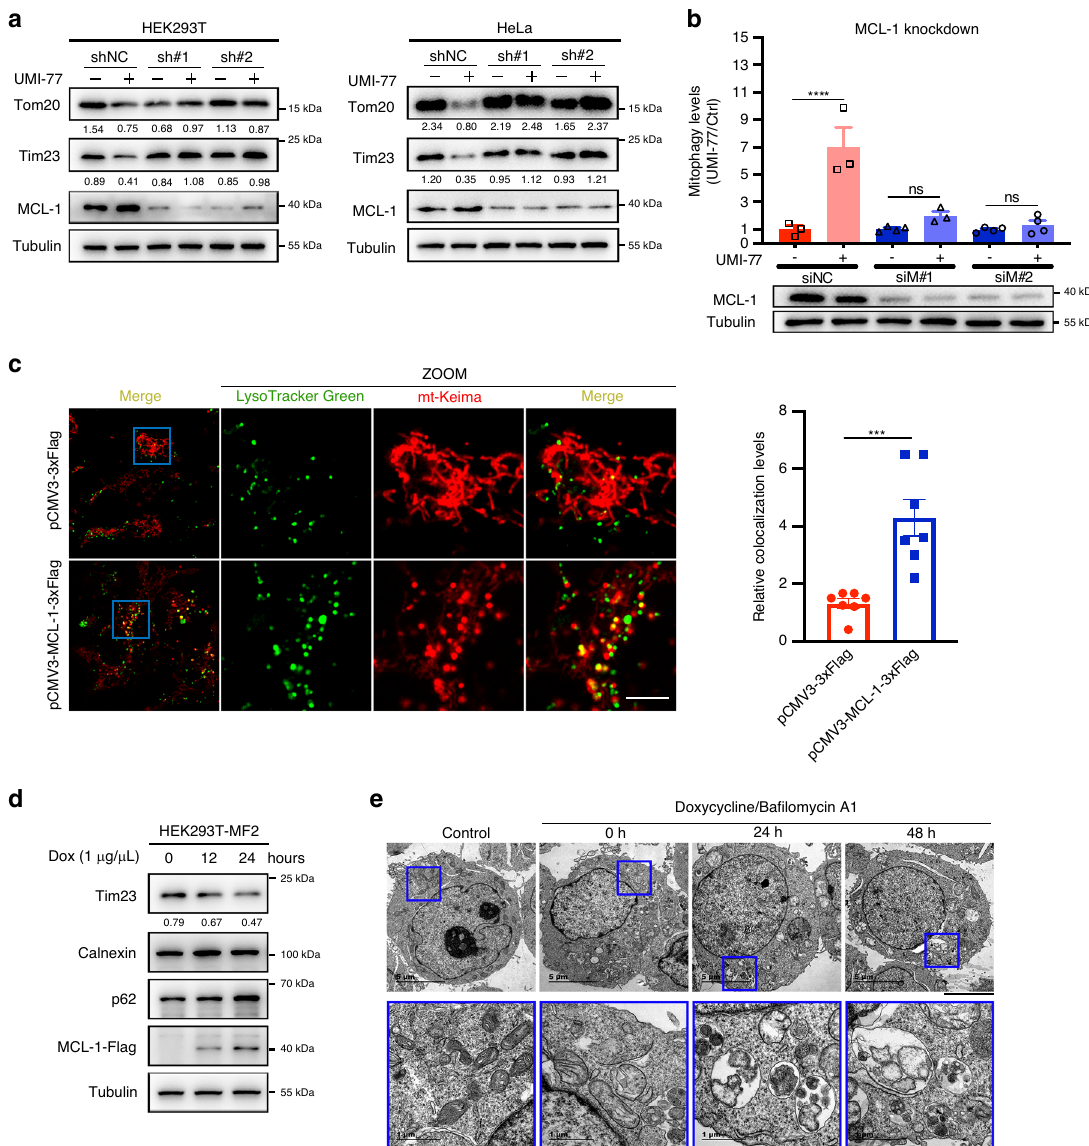
Fig. 2 MCL-1 promotes mitophagy and is required for UMI-77-induced mitophagy. a HEK293T cells were transfected with MCL-1 shRNA for 60 h and treated with 5 µ M UMI-77 for 12 h. Cell lysates were immunoblotted for mitochondrial marker proteins (Tom20, Tim23). The numbers under the blots represent the gray scale quanti fi cation (Tom20/Tubulin, Tim23/Tubulin). shNC: scrambled shRNA. b HEK293T-mt-Keima cells were transfected with indicated siRNA for 60 h, treated with UMI-77 (5 µ M) for 12 h, The siRNA knockdown ef fi ciency was shown using western blot and the mitophagy levels were quanti fi ed. One-way ANOVA (data represent mean ± S.E.M.; n = 3. **** p < 0.0001, ns, not signi fi cant.). siNC: scrambled siRNA. c HEK293T-mt- Keima cells were transfected with pCMV3-MCL-1-3xFlag and pCMV3-3xFlag plasmid, for 24 h, stained with LysoTracker Green for 30 min and imaged using fl uorescence microscopy. Scale bar, 5 µ m. Quanti fi cation of the number of LysoTracker-positive dots colocalized with mt-Keima in cells were analyzed by two-tailed t test. (data represent mean ± S.E.M.; n = 7 *** p < 0.001 ( P = 0.0007)). d MCL-1-expressing HEK293T-MF2 cells were treated with 1 μ g/mL doxycycline (Dox) for the indicated times, cell lysates were immunoblotted with indicated antibodies. The numbers under the blot represent the gray scale quanti fi cation (Tim23/Tubulin). e HEK293T-MF2 cells were treated with 1 μ g/mL doxycycline for the indicated times, treated with Ba fi lomycin A1 for 6 h, and analyzed by transmission electron microscopy (TEM). Insets (blue boxes) show mitochondria and the autophagosomes engul fi ng mitochondria. Scale bars, 5 µ m; insets: Scale bar, 1 μ m. Source data are provided as a Source Data fi